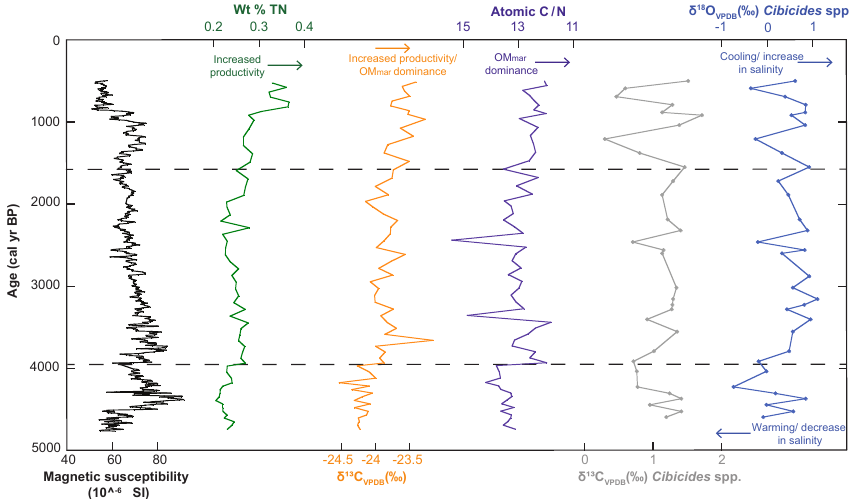
Figure 7. Downcore parameters against age, 36P4, Hanfield Inlet: magnetic susceptibility (MS), wt% nitrogen (TN), δ 13 C and atomic C / N of bulk sediment, and δ 13 C and δ 18 O of benthic foraminifer Cibicides spp. See text for error on replicate measurements. The dashed horizontal lines at ∼ 4000 and 1600yrBP break the core into three sections based on prominent shifts across multiple proxies. From 4000 to 1600yrBP, fjord conditions are relatively stable, as indicated by relatively unchanging MS, wt% TN, δ 13 C and atomic C / N. This interval is characterised by more negative δ 13 C and higher C / N, indicating a higher contribution from OM terr , increased stratification and decreased SHWW influence at this time. From 1600 to 900yrBP, increasing wt%TN, more positive δ 13 C and more negative C / N indicates a shift to OM mar dominance, signifying a strengthening of the SHWW at this time. Paired fluctuations in benthic foraminifer δ 13 C and δ 18 O demonstrate increased variability during this period, associated with westerly wind-driven changes in shelf hydrography. From 900 to 500yrBP, a decrease in MS accompanied by an increase in wt% TN indicates an increase in productivity (also reflected by more positive δ 13 C), rather than strengthened winds at this